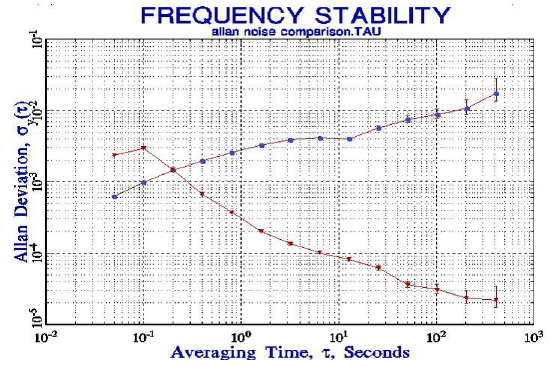
Figure 4: Allan deviation curves for a non-compensated (blue dots) and compensated (red dots) white noise signal, with an amplitude of